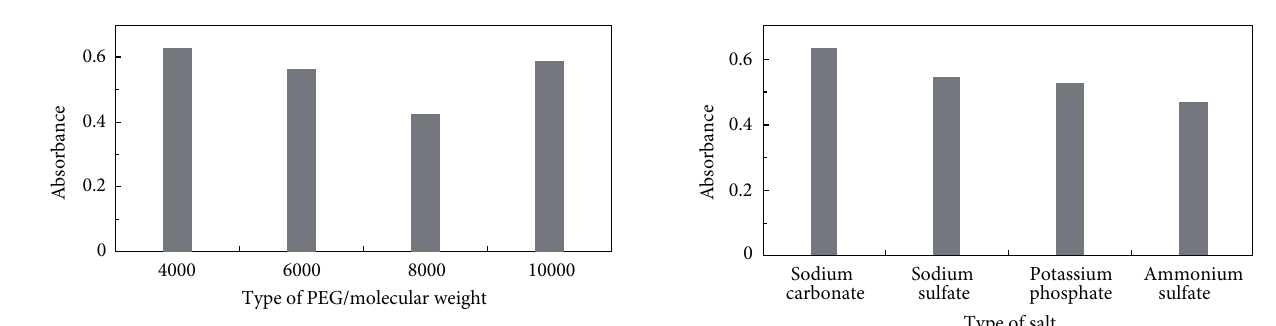
F 5: Effect of type of salt on the extraction efficiency. Exper- imental conditions: volume of buffer; 9mL, pH of sample; 5.5, amount of PEG 4000; 4gr, amount of salt; 2.5gr, temperature; 35 C, centrifuging time; 10min, 4ng/mL of brilliant blue.